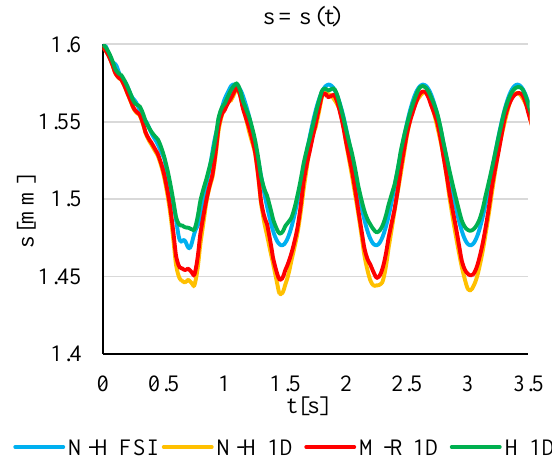
Fig. 9. Wall thicknesses s of the thick-walled tube.